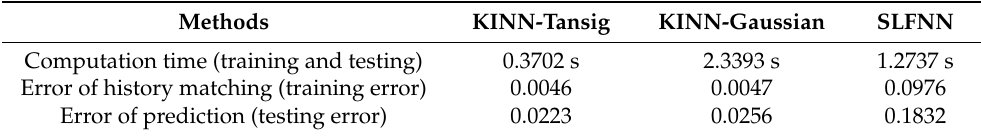
Table 3. The time consumption, training error (MSE) and testing error (MSE) of KINN-tansig, KINN-Gaussian and SLFNN in the streak reservoir